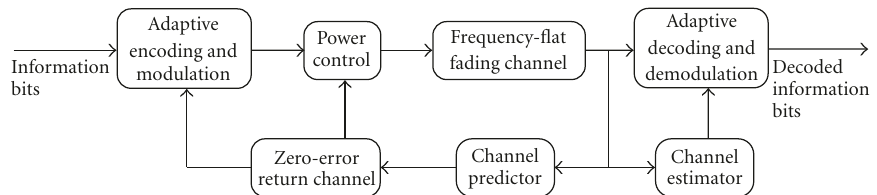
Figure 1: Adaptive coded modulation system [15] ( c (cid:2) 2006